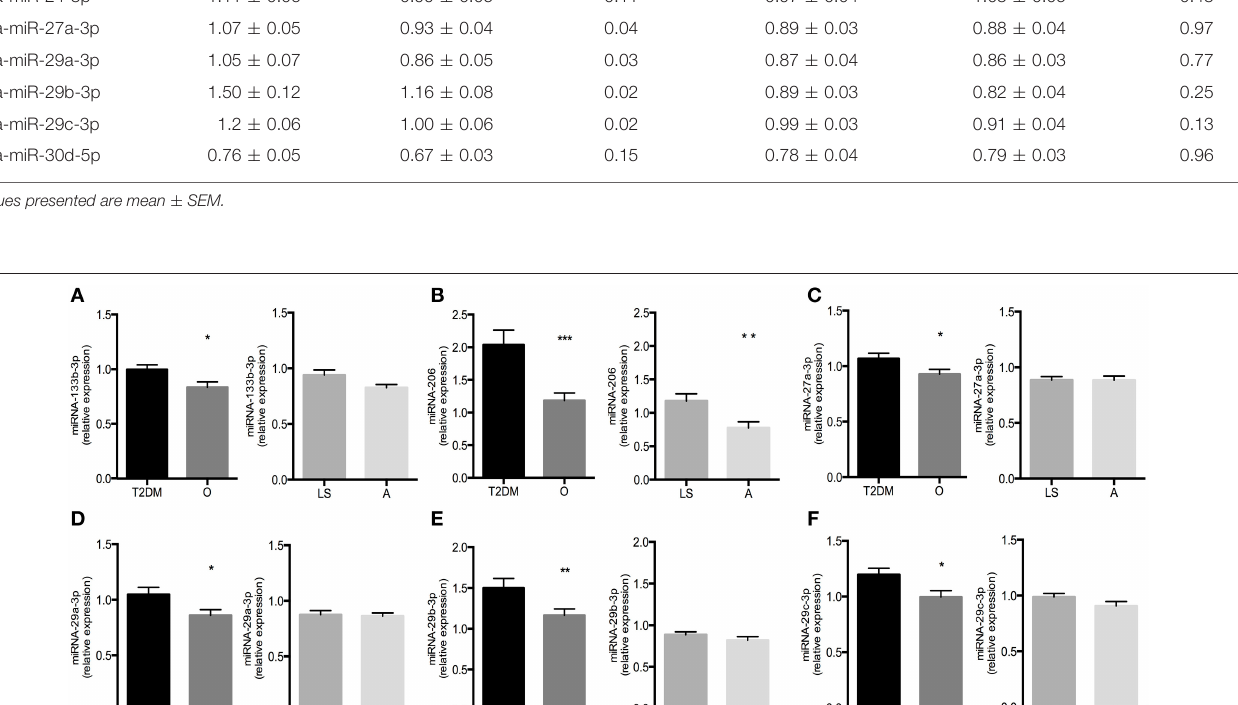
Frontiers in Physiology |